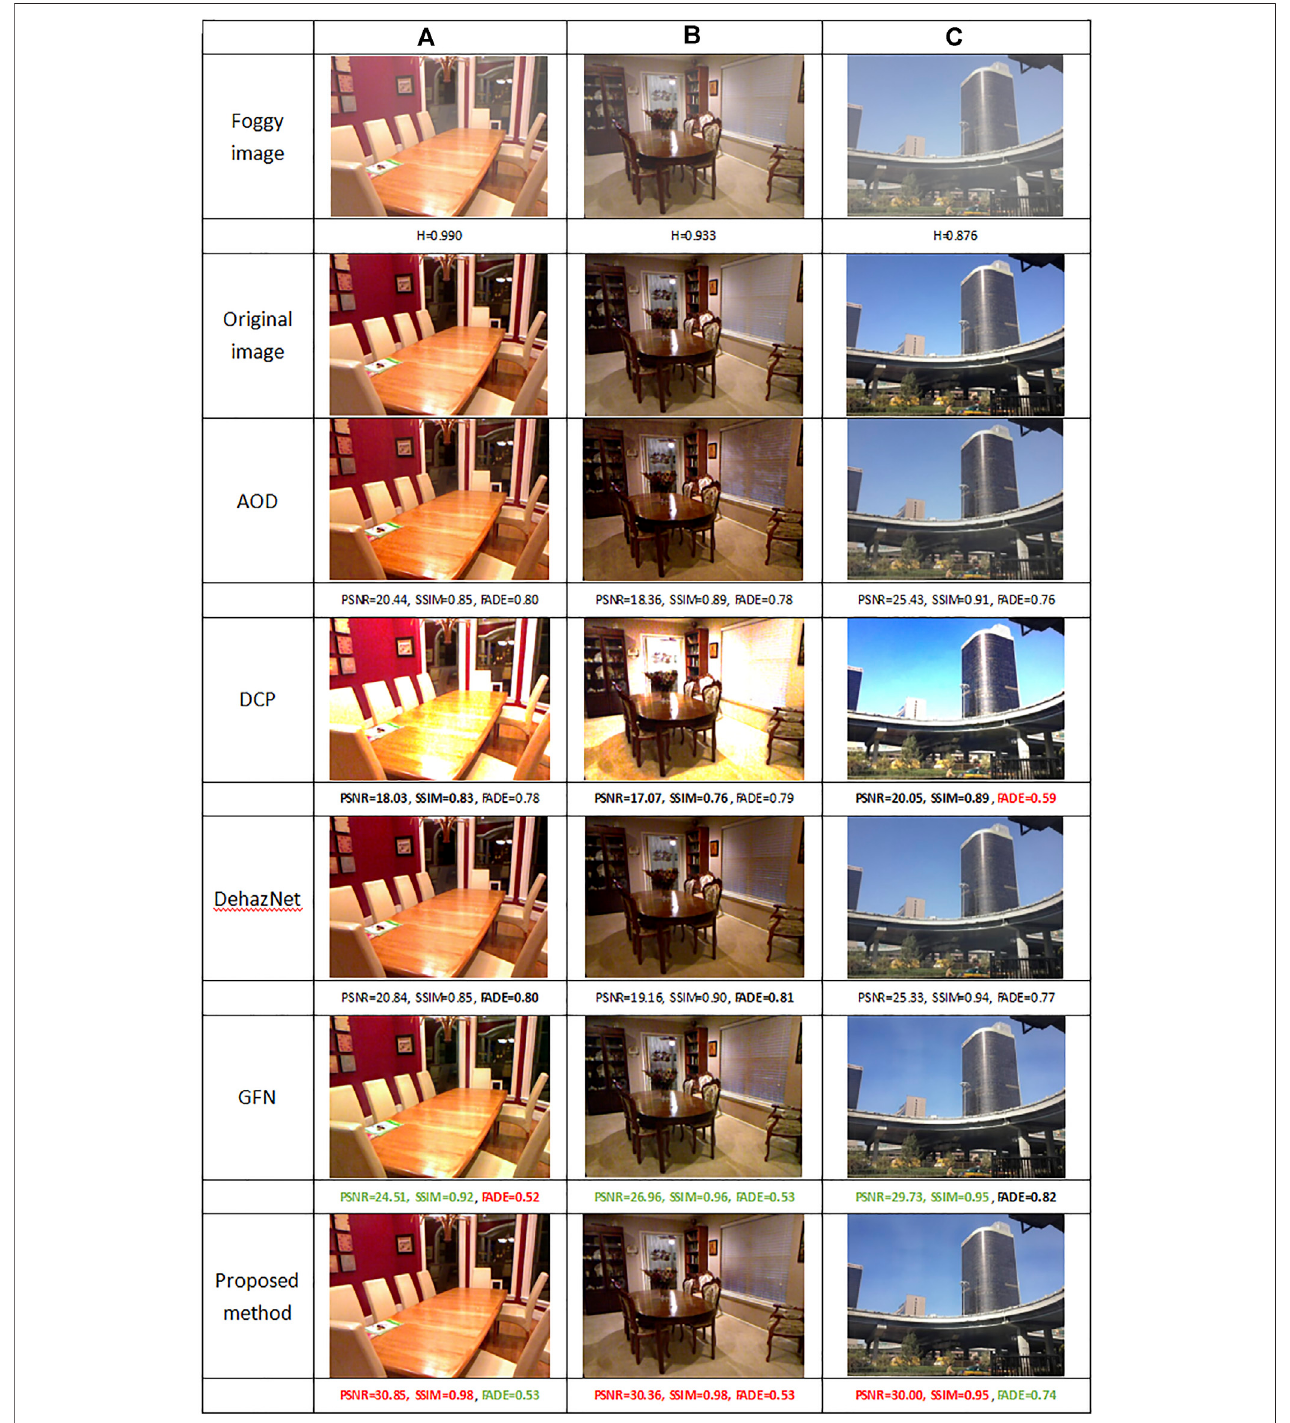
FIGURE 5 | Some dehazing images and their image quality metrics of synthetic foggy data in SOATS.